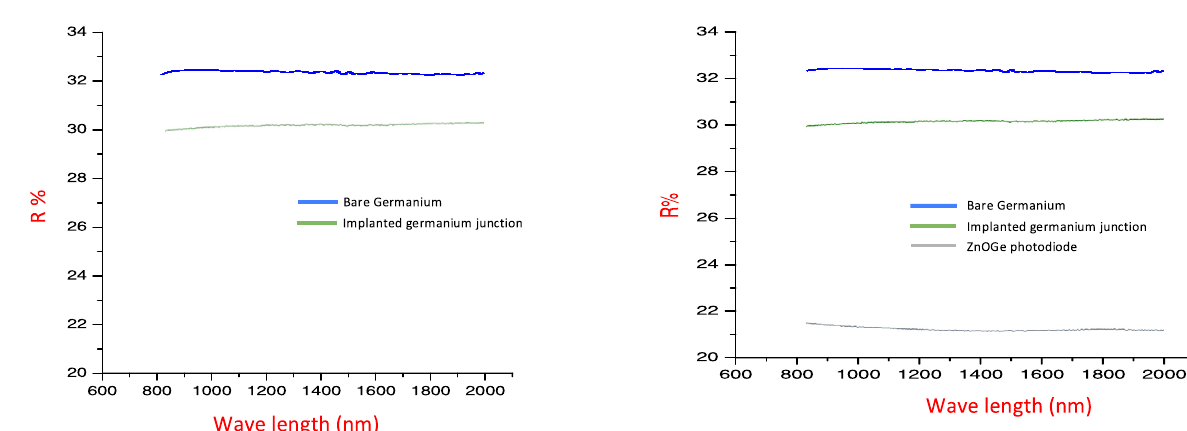
Fig. 4. Re fl ectivity of the